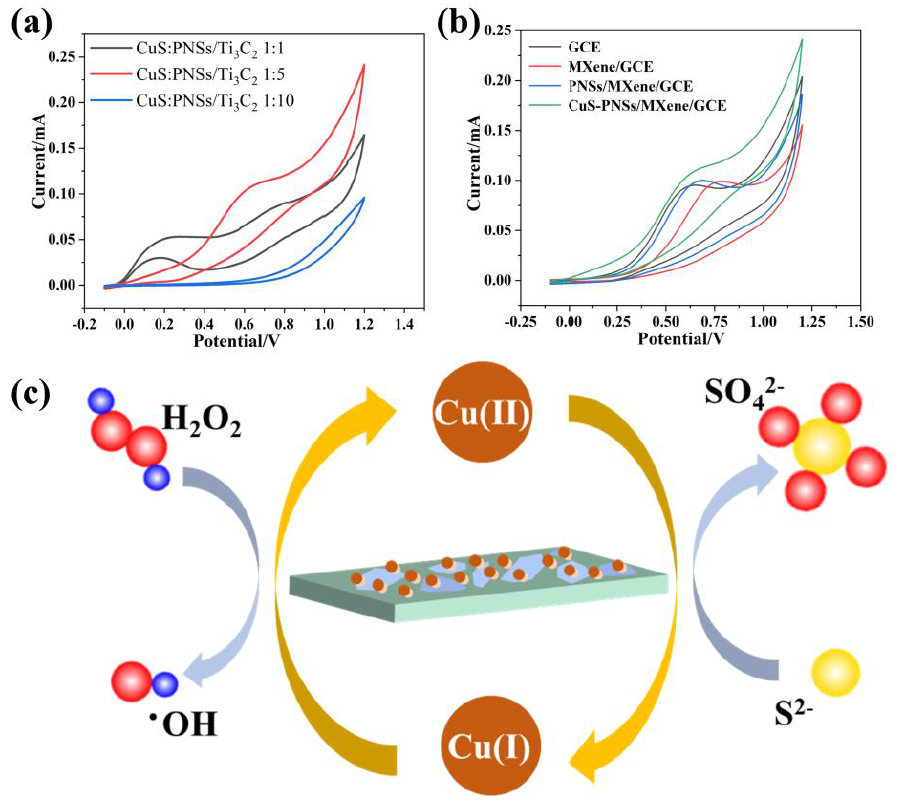
Figure 4. Electrochemical tests of different GCEs. ( a ) CV curves of different ratios of CuS and PNSs/Ti 3 C 2 in the H 2 O 2 concentration of 5mM; ( b ) CV curves of GCE, Ti 3 C 2 /GCE, PNSs/Ti 3 C 2 /GCE, and CuS-PNSs/Ti 3 C 2 /GCE; ( c ) electrochemical oxidization – reduction reaction mechanism by CuS NPs.